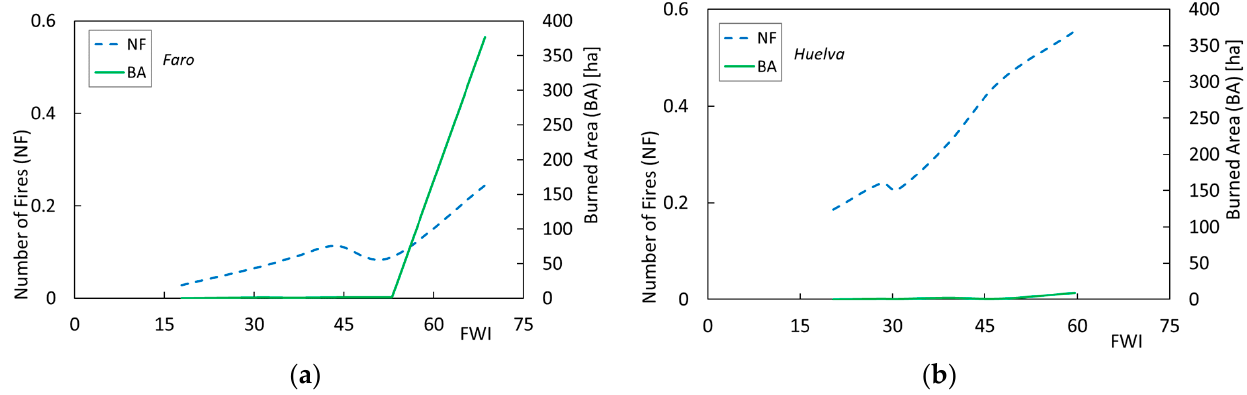
Figure 6. Average number of daily fires (NF) and burned area (BA) as a function of FWI for: ( a ) Portuguese district of Faro; and ( b ) the Spanish province of Huelva.